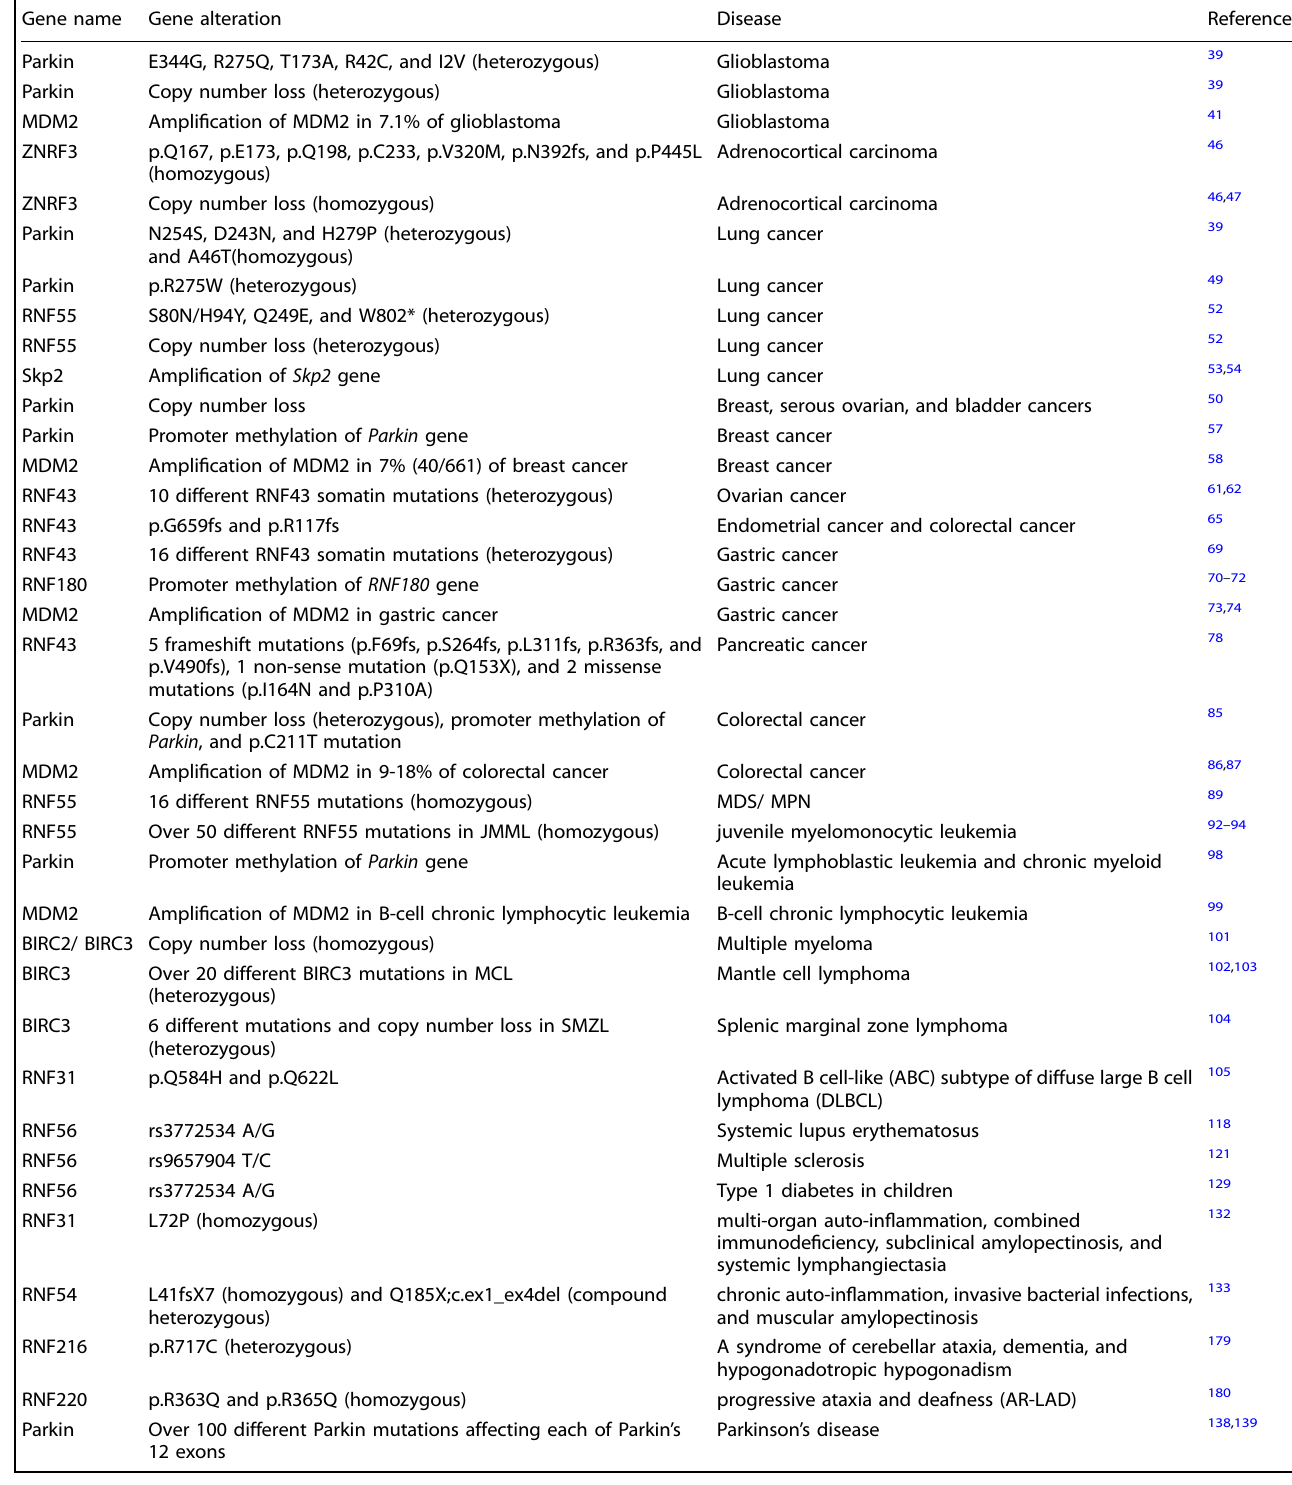
Table 1. Reported RNF Proteins Mutations in Human Patients Gene name Gene alteration